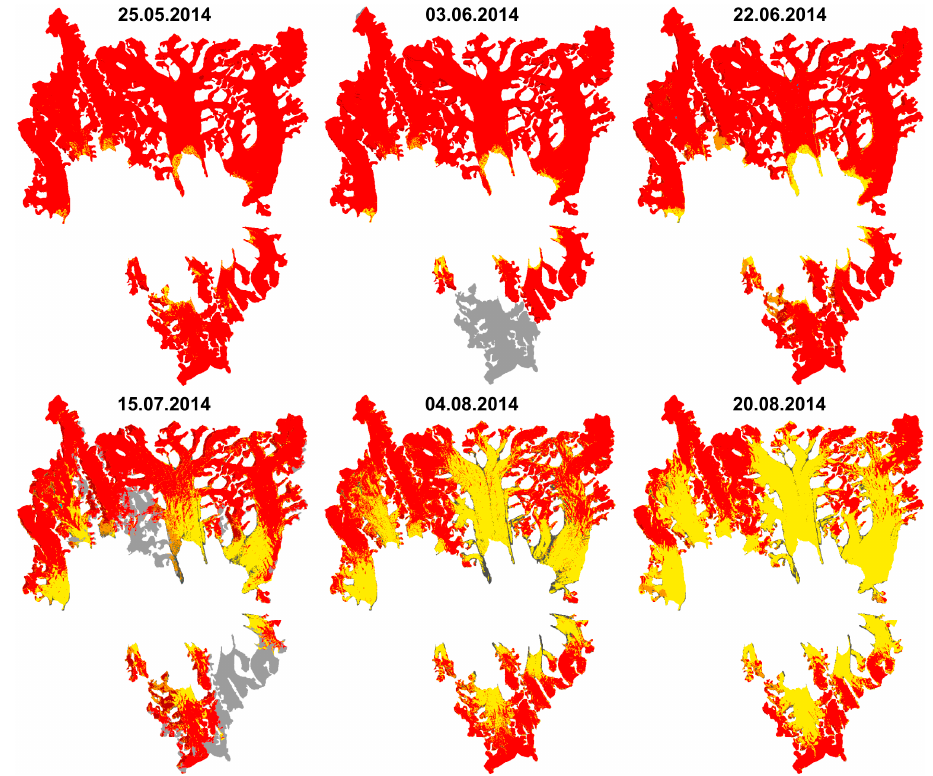
Figure 4. Variability of the Snow-Covered Area on Hornsund glaciers at individual stages in the melting period of 2014, based on Landsat 8 images: red—snow cover; yellow—glacier ice; black—debris; grey—cloud mask.